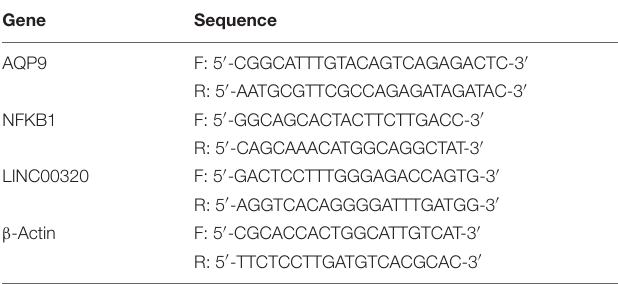
TABLE 1 | Primer sequences for reverse transcription quantitative polymerase chain reaction. Gene